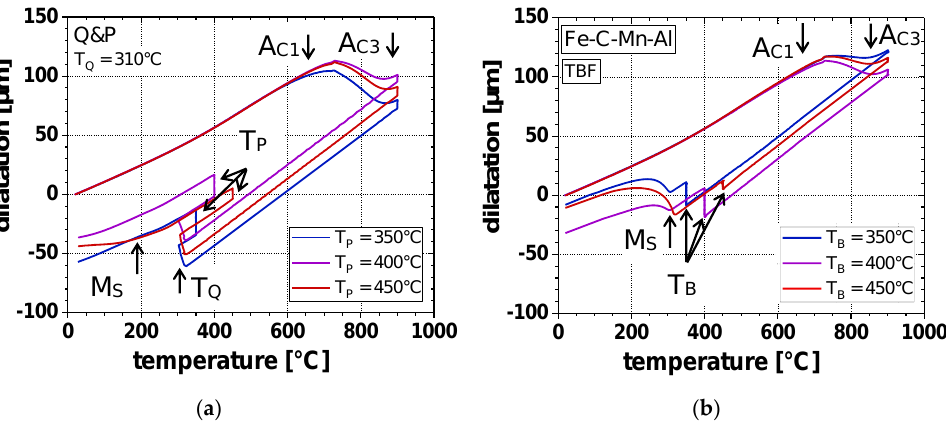
Figure 3. Dilatometric curves at different T P ( T B ) of ( a ) Q&P heat-treatment ( T Q = 310 °C) and ( b ) TBF heat-treatment.